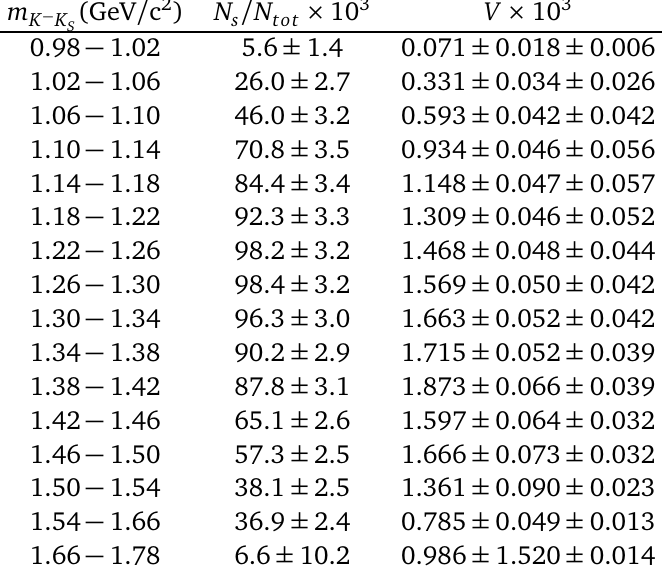
ν . τ decay, in bins of m K − K S S